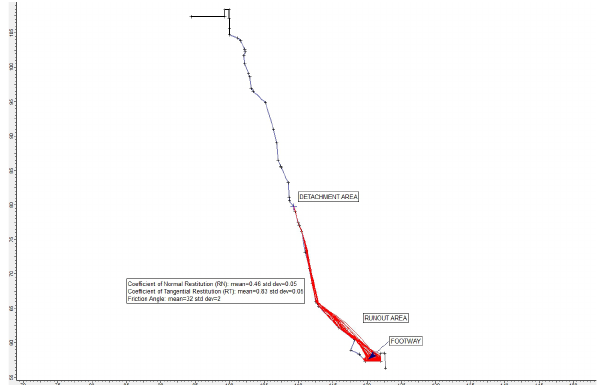
Fig. 8. Back analysis of known rockfall event, which occurred in section C in 2010.